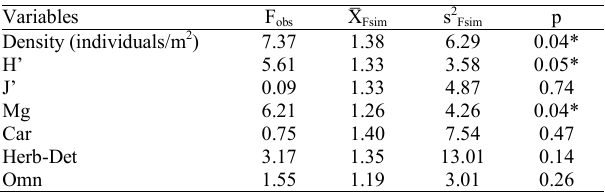
Table 2. ANOVA results for total fish density, trophic groups and species diversity for both groups of streams (n